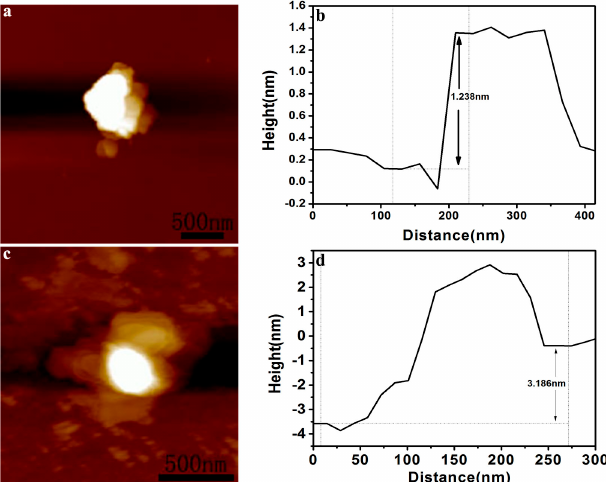
Figure 2. Atomic force microscopy (AFM) images of BiOBr-Ov ( a ) and BiOBr ( c ); cross-sectional line profiles of BiOBr-Ov ( b ) and BiOBr ( d ).